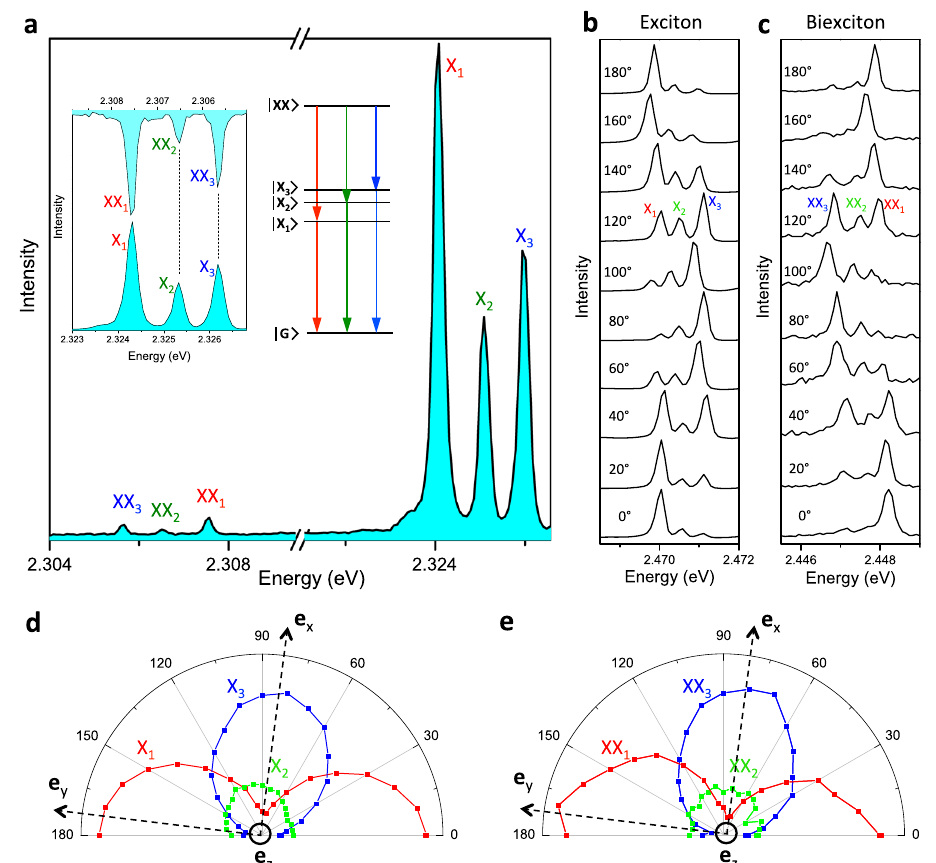
Fig. 3 | Biexciton-to-exciton transitions and biexciton binding energy in perovskite NCs. a Low-temperature PL spectrum of a single CsPbBr 3 NC at high excitationintensity(50kWcm − 2 )and7T.ThelinesnamedX 1 ,X 2 ,X 3 areassignedto the exciton triplet recombination ZPLs. The red-shifted lines named XX 1 , XX 2 , XX 3 are assigned to the biexciton-to-exciton transitions and perfectly map onto the exciton triplet ZPLs under mirror image (left inset), allowing a straightforward correspondenceofthetransitionlines(rightinset).ThespectraltrailofthisNCover time is shown in Supplementary Fig. 9. b , c Polarized PL spectra zoomed on the